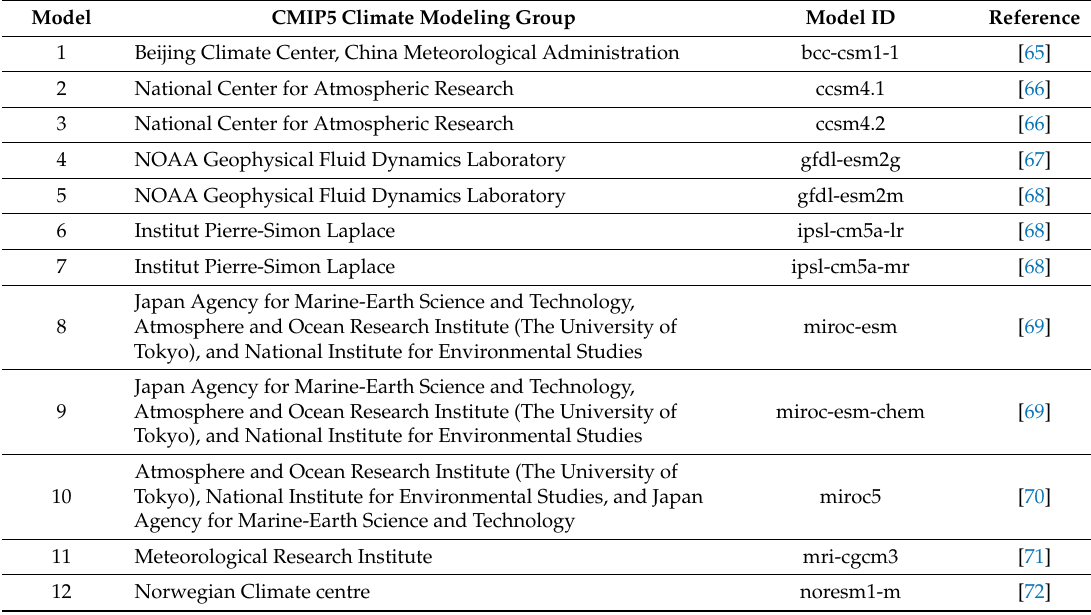
Table 2. List of the General Circulation Models used in this